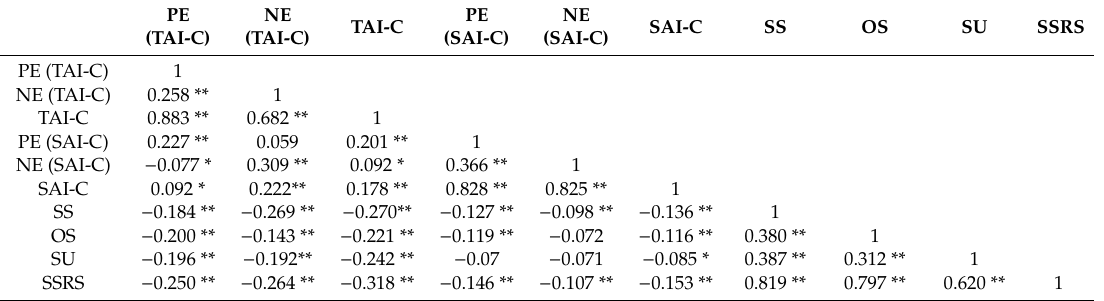
Table 4. Correlation analysis among